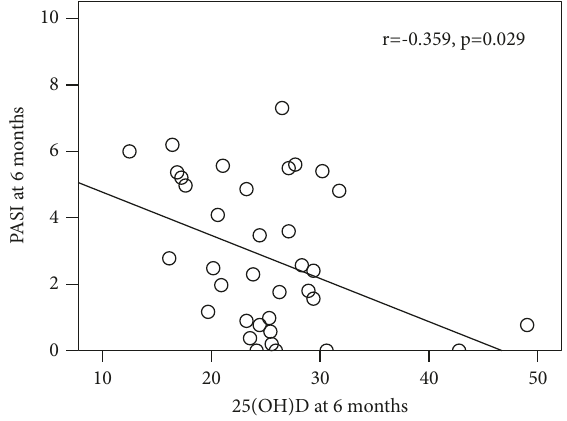
Figure 3: Relationship between the serum 25(OH)D level and severity of psoriasis PASI, Psoriasis Area and Severity